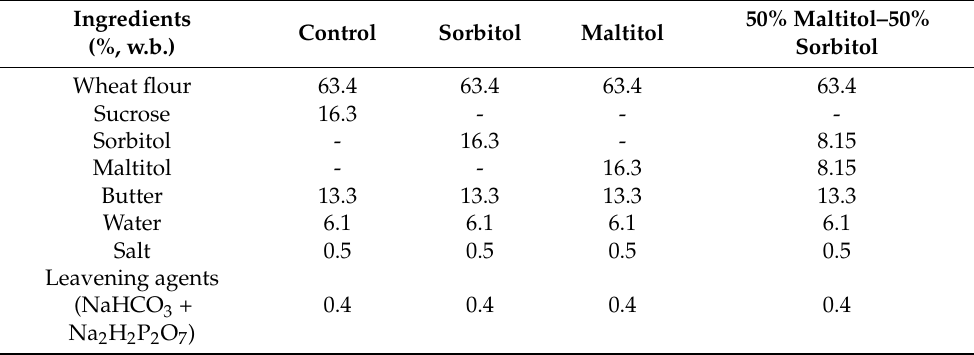
Table 1. Biscuit dough formulations (%, wet basis